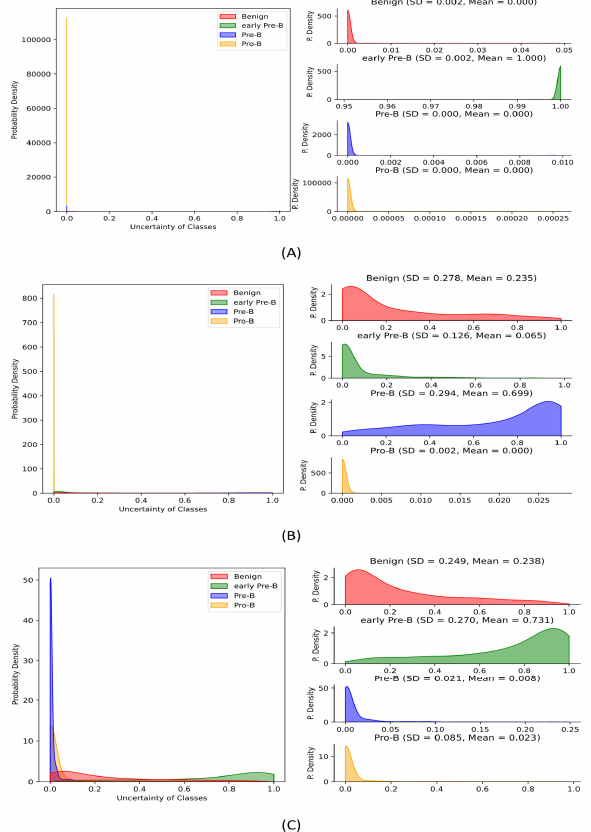
Figure 5. Examples of uncertainty quanti fi cation for ALL dataset using custom CNN architecture: ( A ) correctly classi fi ed with low uncertainty; ( B ) correctly classi fi ed with high uncertainty; and ( C ) misclassi fi ed with high uncertainty.